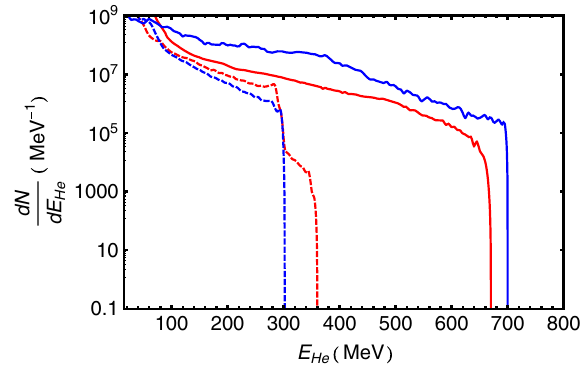
FIG. 1. The spectra of helium-4 (blue curves) and helium-3 (red curves) ions accelerated from a 6 λ liquid target by 1 PW (dashed curves) and 2 PW (solid curves) laser pulses in the > 0 forward direction, i.e., p He